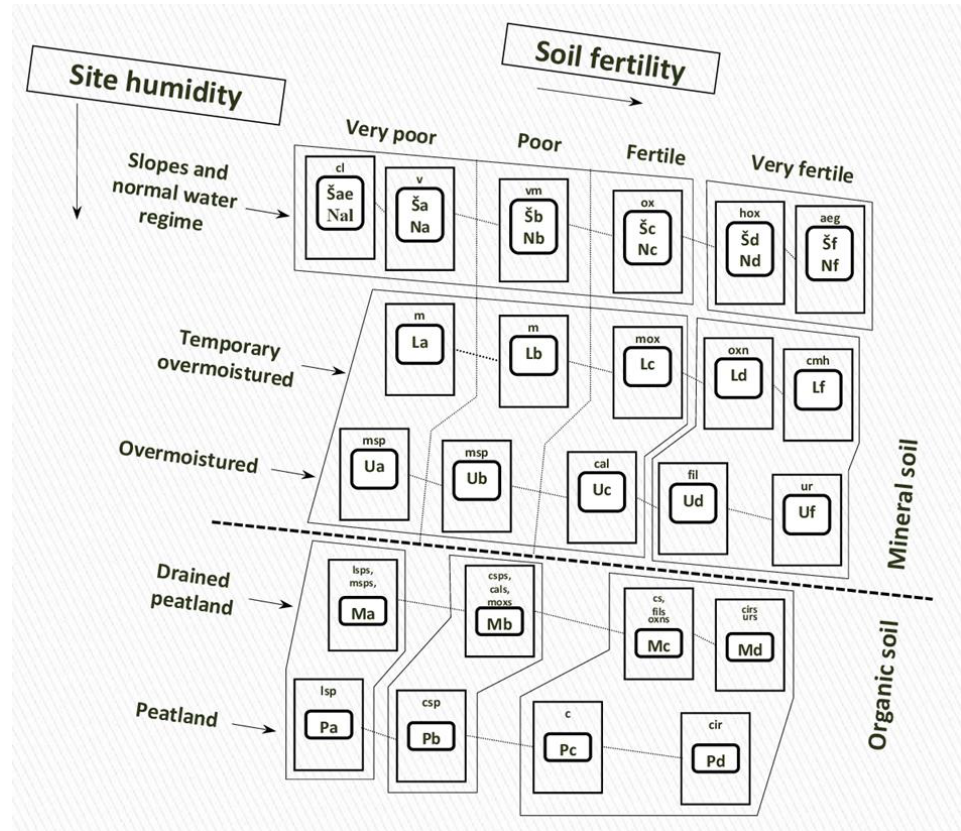
Figure 1. Lithuania’s forest site type scheme. The bold codes refer to Lithuanian’s forest site types based on soil fertility and moisture, and the small non-bold letters refers to the forest vegetation type series [18,20,23]: N — normally moist, L — temporarily over moist, U — over moist, P — peatland, and f — very eutrophic soils, d — eutrophic soils, c — mesotrophic soils, b — oligotrophic soils, a — very oligotrophic soils; aeg— Aegopodiosa , c— Caricosa , cal— Calamagrostidosa , cir—